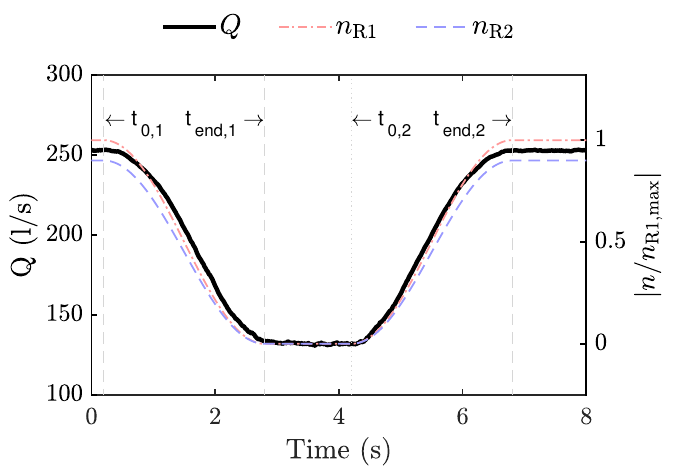
Figure 4. Flow rate (left axis) and runner rotational speeds (right axis) as a function of time during the turbine mode transients. The rotational speeds are normalised with the initial rotational speed of Runner 1. The annotated times correspond to the start/end times of the changes in runner rotational speeds (see Figure 2a).